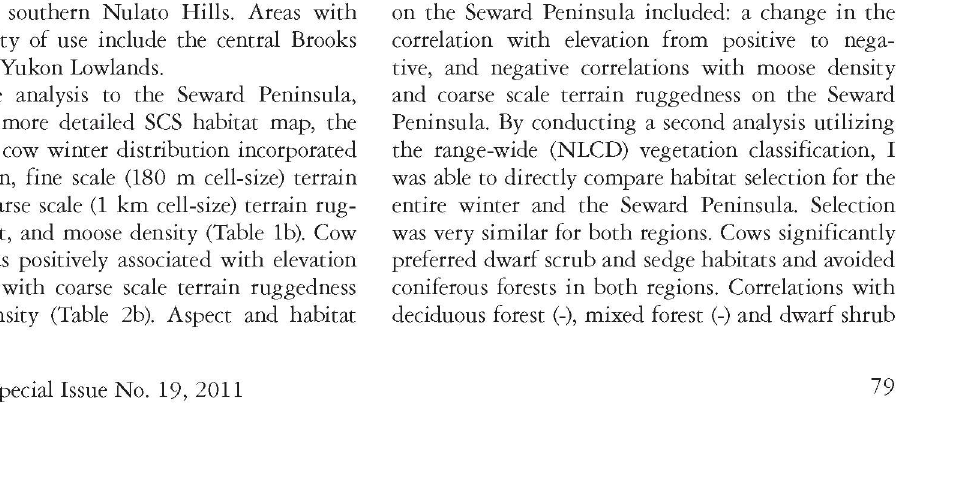
Fig. 3. Resource suitability map for Western Arctic Herd cow caribou during the winters (October through April) from 1999-2005, northwest Alaska. Lighter shades represent greater suitability (relative probability of selection). were significantly correlated with cow distribution (Table 2b). Cows significantly preferred